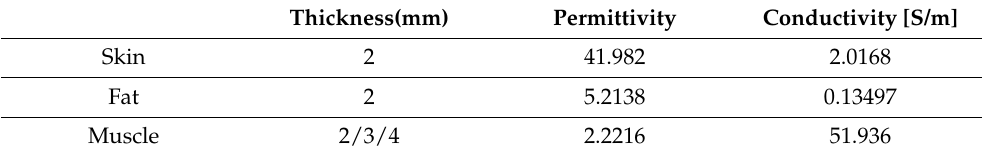
Figure 14. ( a ) Sensing model of FR-4 based MA. ( b ) S 11 and absorption plotting at different thicknesses of human muscle. Table 2. Permittivity and conductivity of skin, fat, and muscle thickness, permittivity, and conduc- tivity.